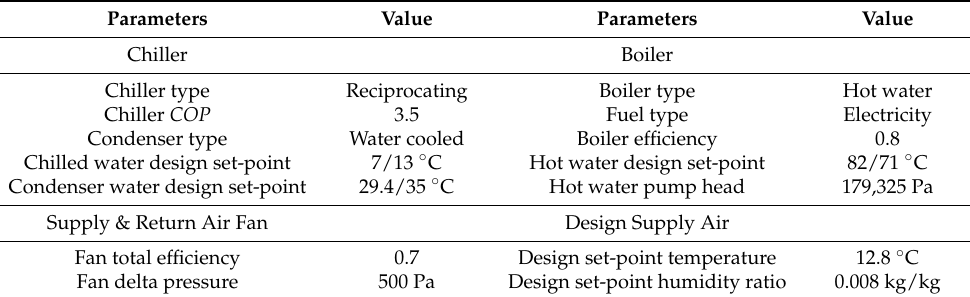
Table 3. Simulation input parameters of the referenced conventional VAV system [57].